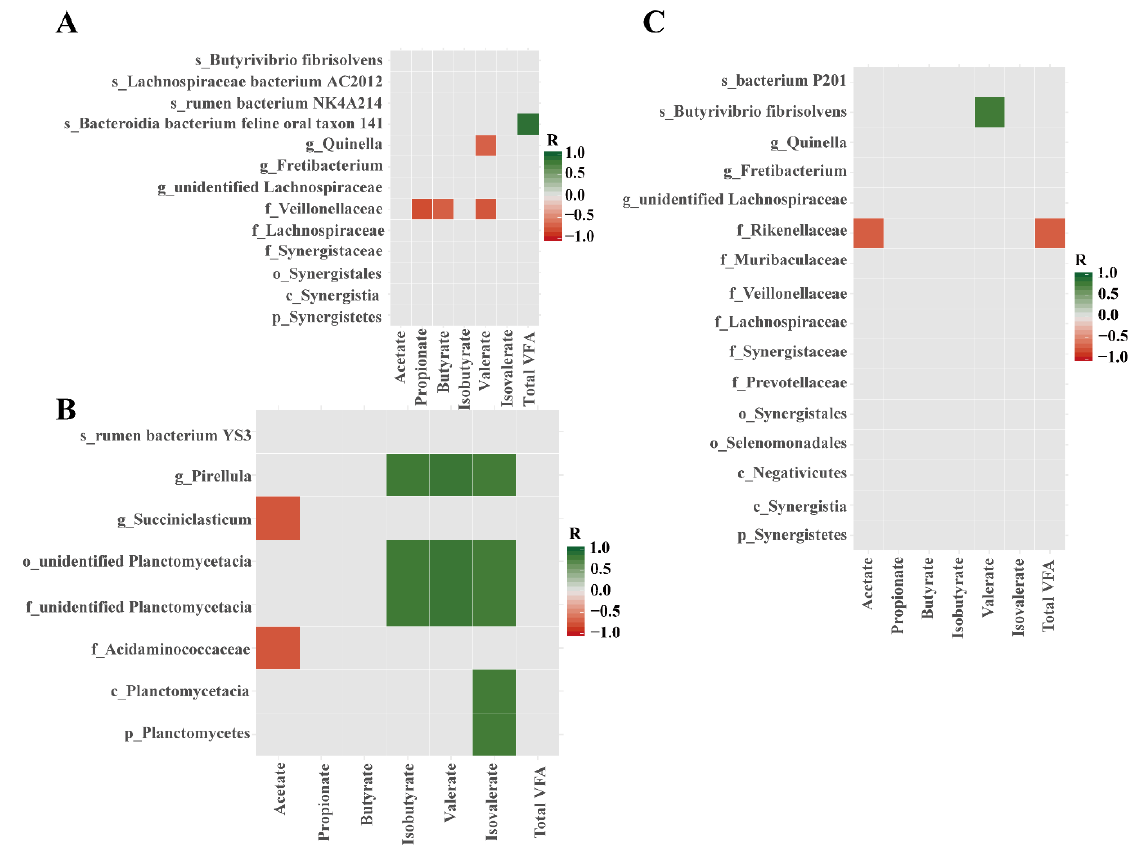
Figure 5. Spearman correlations between bacterial biomarkers and VFAs in the GR ( A ), IF ( B ), and SF ( C ) groups. Correlations with a threshold of statistical significance at p < 0.05 were visualized. The green color represents a positive correlation and the red color represents a negative correlation.